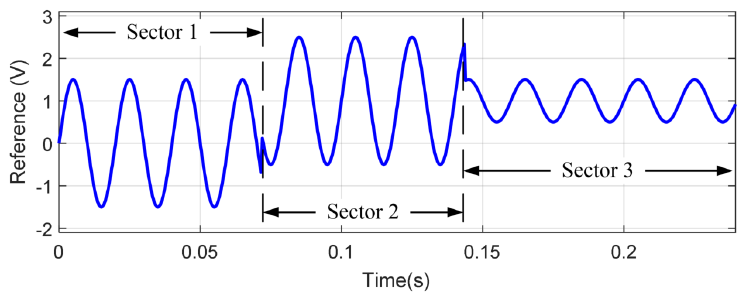
Figure 3. Reference signal for test